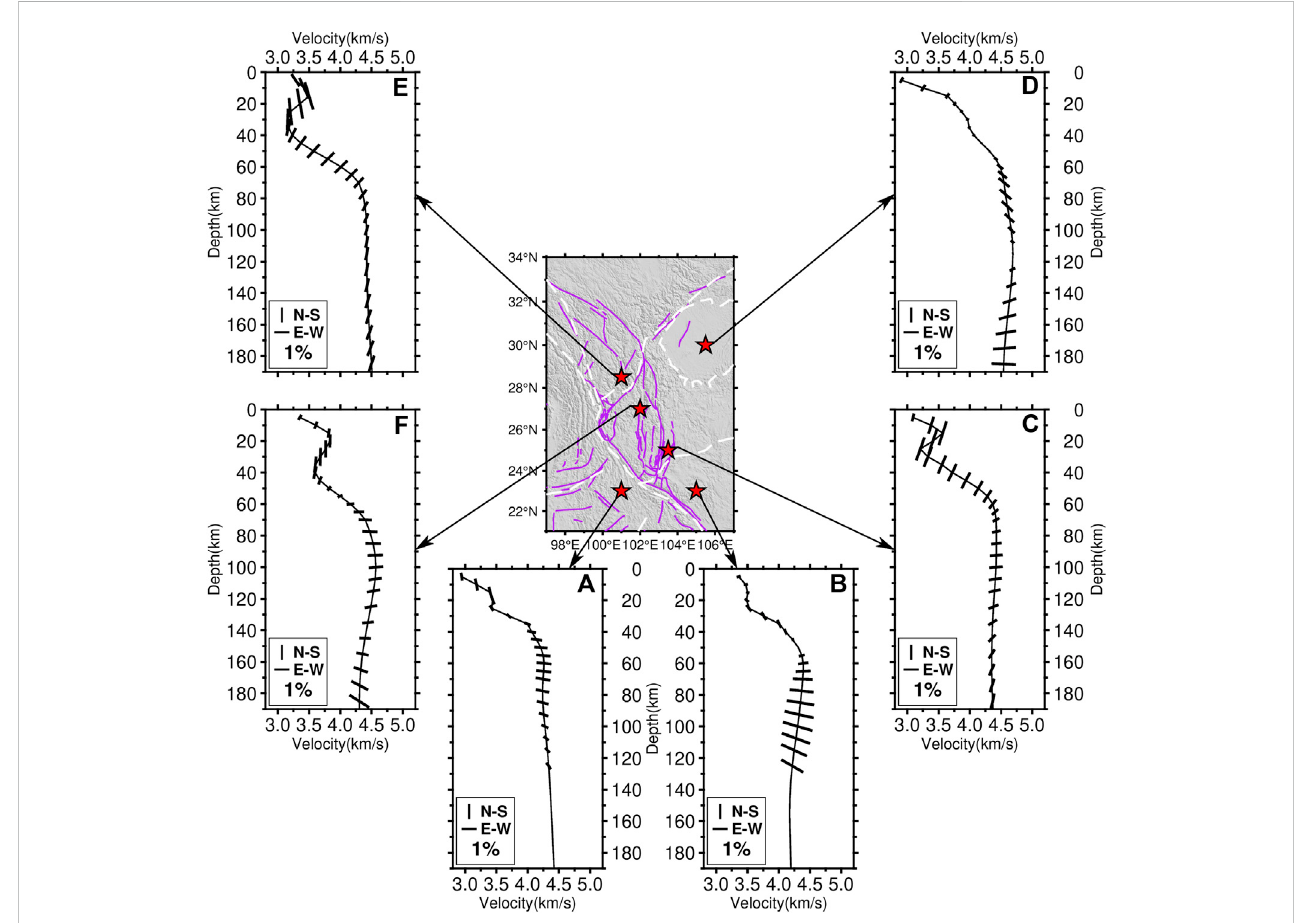
FIGURE 10 Shear wave velocity and azimuthal anisotropy varied with depth at six locations (A – F) marked by the red stars in the study area. Azimuthal anisotropy is not shown below 135 km depth in (A) and (B) due to lack of resolution south of 24 ° N.